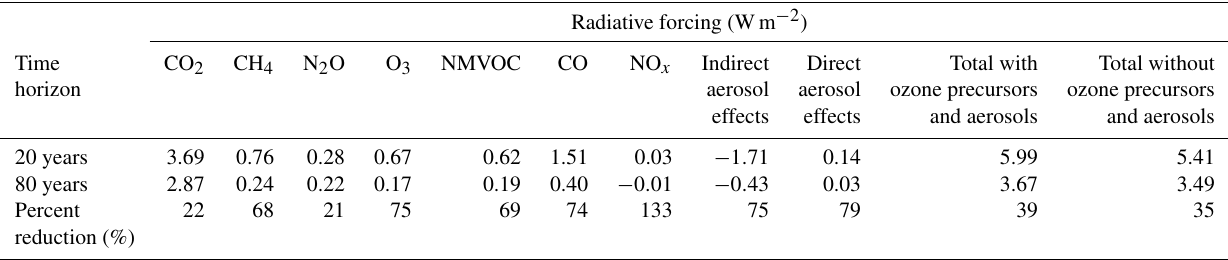
Table 4. Cumulative mean radiative forcing at 20- and 80-year time horizons post-fire for different gaseous and aerosol emissions from the 2015 fire season under the RCP 4.5 future scenario. Percent reduction refers to the loss in radiative forcing when considering an 80-year time horizon compared to 20